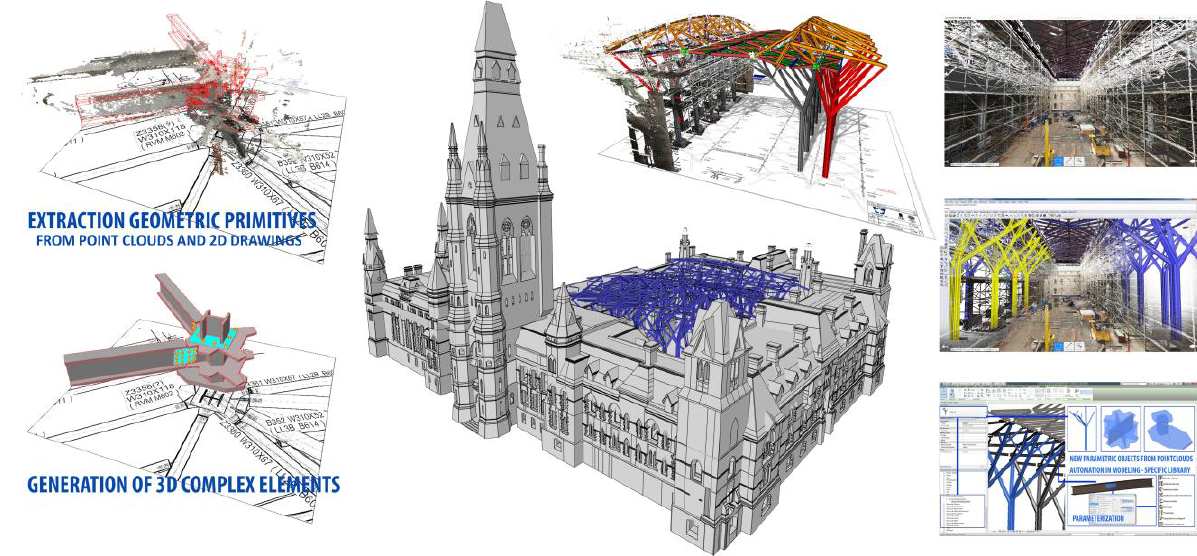
Fig. 3. The generation process of Modern Structure of West Block. Geometric primitives and 3D solids can be extracted from scans. The deviation value between point clouds and 3D objects is 2